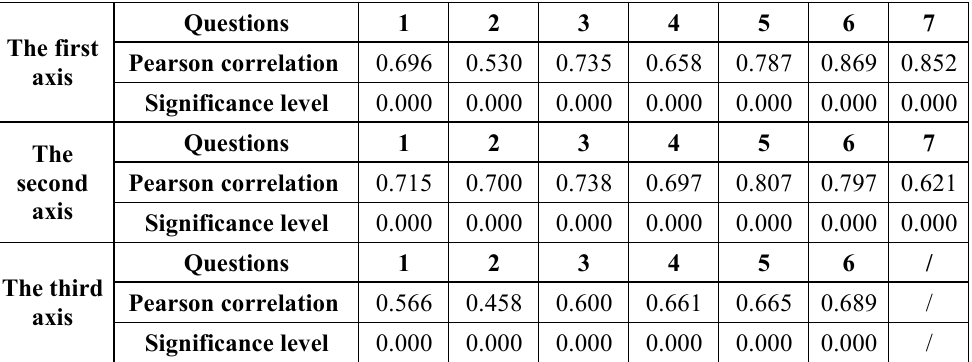
Table 2. Correlation of Axis Responses with Total Axes